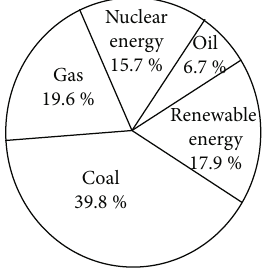
Figure 2: Generate electricity from various